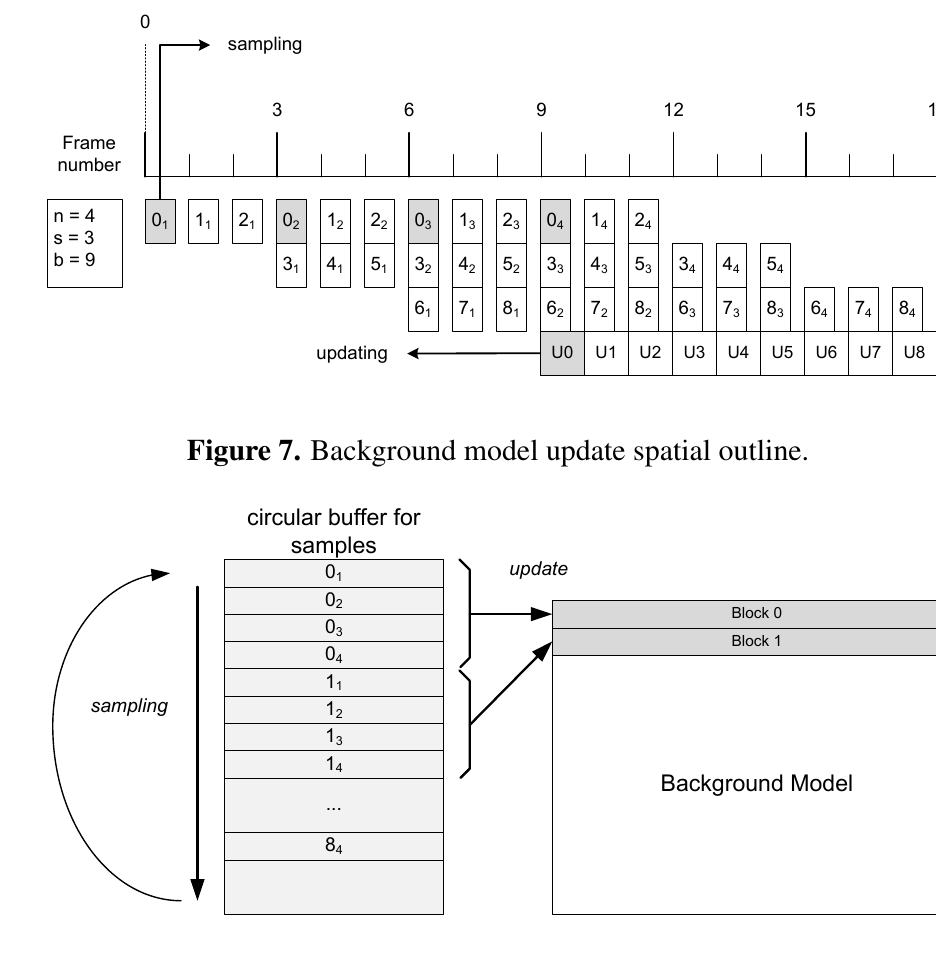
Figure 6. Background model update process by continuous background model learning.